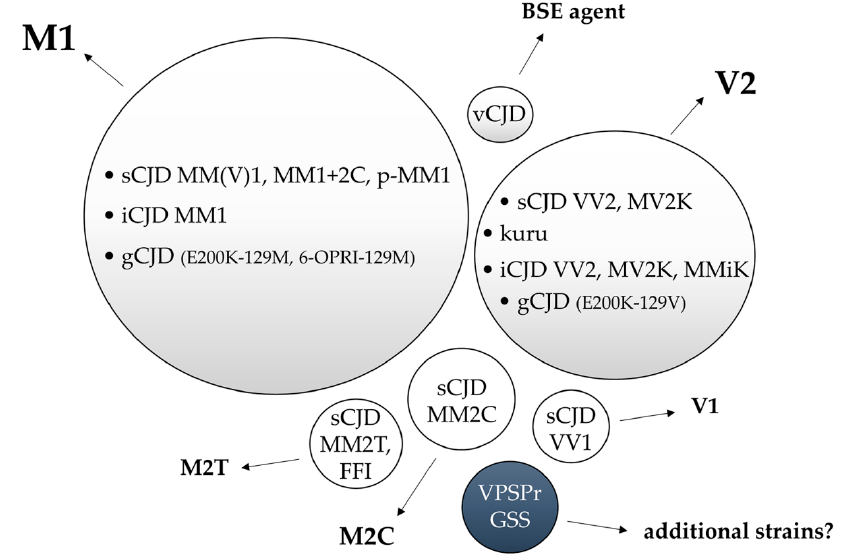
Figure 3. Representation of the relationship between human prion disease subtypes and the isolated strains by experimental transmission. Bubble sizes reflect the relative prevalence of each disease subtype / strain. In light grey, the phenotypes related to prion strains with documented human-to-human transmission. In white, experimentally transmitted phenotypes lacking documented human-to-human transmission. In blue, the prion disorders that transmitted amyloid-PrP in the absence of clinical disease. In full agreement with the disease epidemiology in humans, the sCJDMM1 inoculum showed a faster transmission in mice expressing human PrP transgene encoding M at codon 129